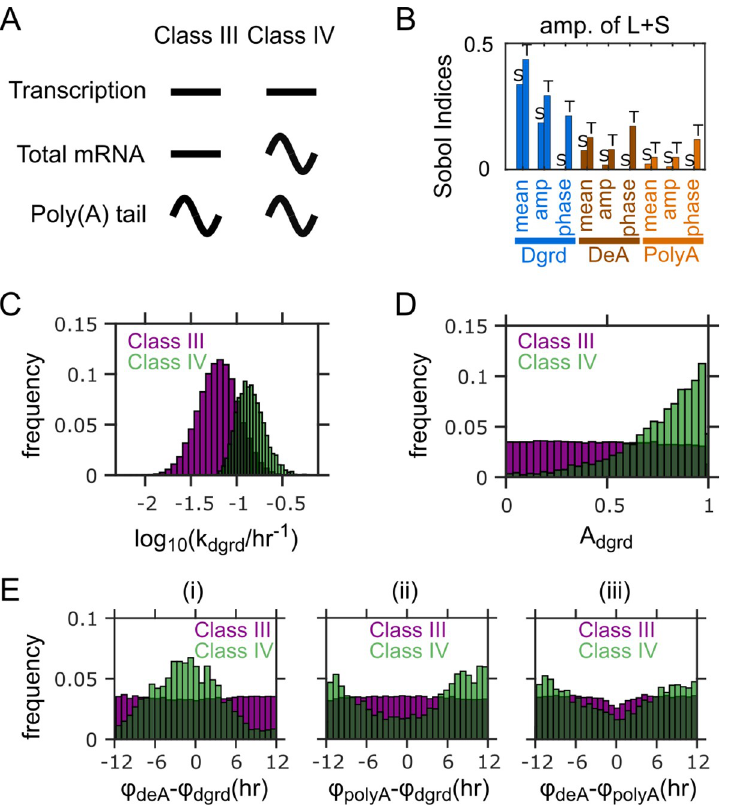
Fig 5. Factors distinguishing between Class III and Class IV PAR mRNAs. (A) Characteristics of Class III and the hypothetical Class IV mRNAs. (B) Sobol indices for the amplitude of L+S (i.e., total mRNA abundance) for the model without rhythmic transcription. Bars with “S” on top: single Sobol indices. Bars with “T” on top: total Sobol indices. (C) Distributions of mean mRNA degradation rates for the two classes. (D) Distributions of relative amplitudes of degradation for the two classes. (E) Distributions of peak phase differences (i) between deadenylation and degradation, (ii) between polyadenylation and degradation, and (iii) between deadenylation and polyadenylation for the two classes. Results in (C-E) from 100,000 simulations with parameters randomly sampled according to Table 1 , but without rhythmic transcription (A trsc = 0). Parameter sets with � 0.2 relative amplitude in L/S ratio and < 0.2 relative amplitude in L+S are defined as Class III, while those with and � 0.2 relative amplitude in both L/S ratio and L+S are defined as Class